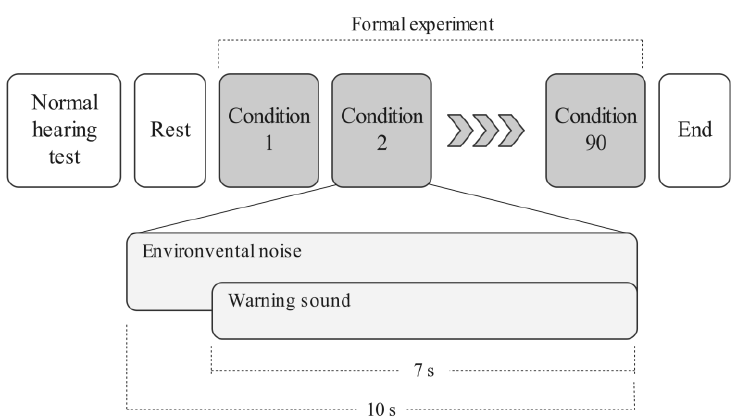
Figure 6. The experimental process in this study.